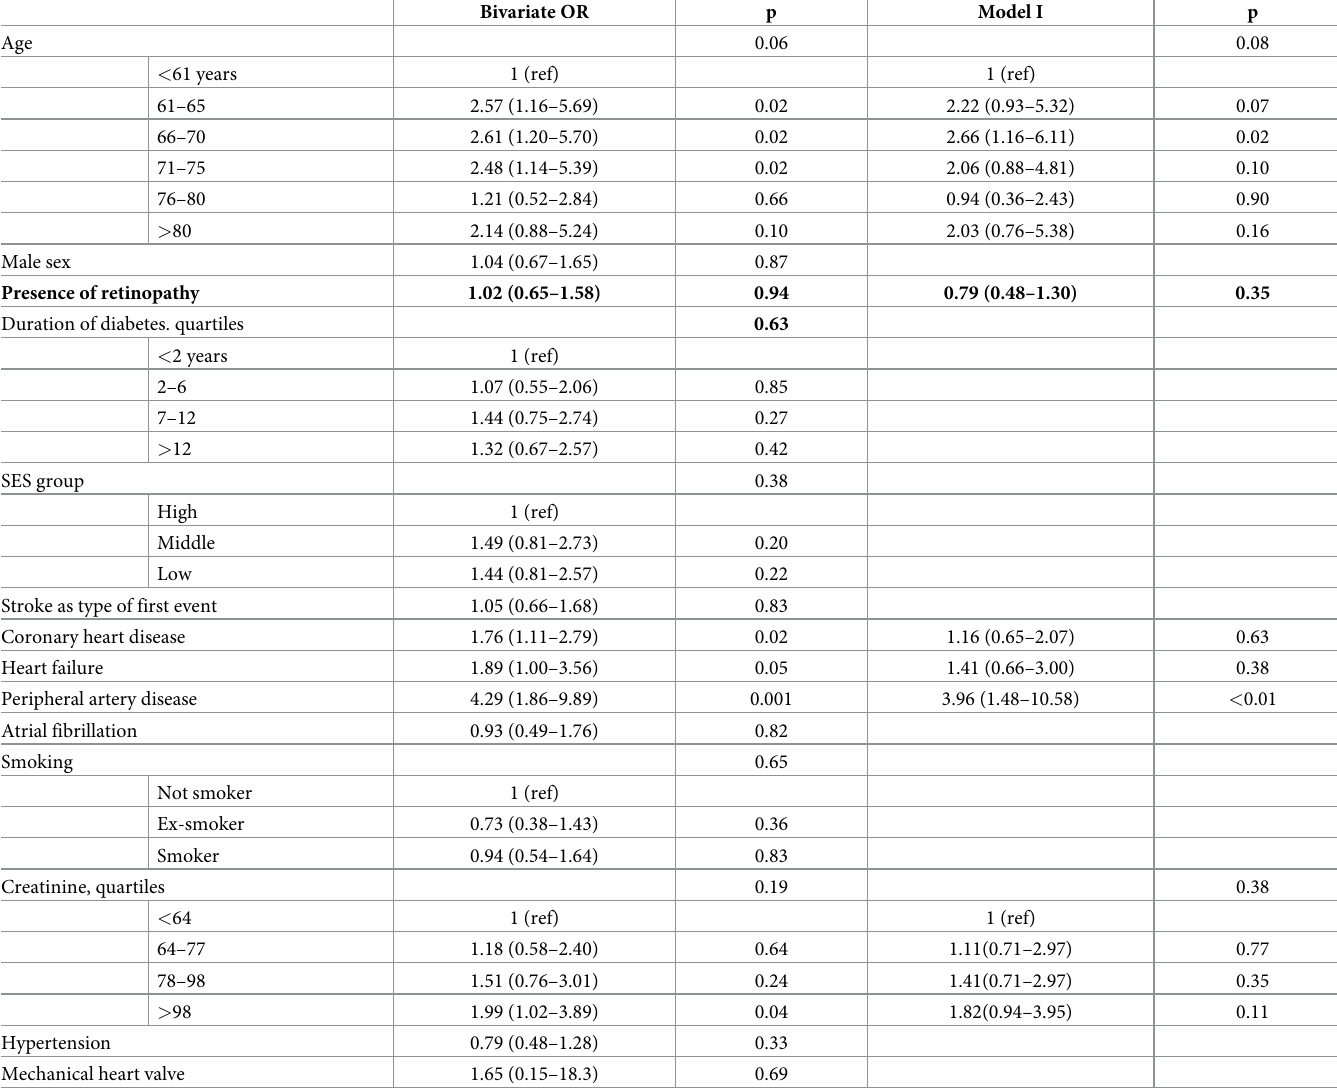
Table 6. Logistic regression in diabetes subjects with presence of carotid stenosis as outcome.